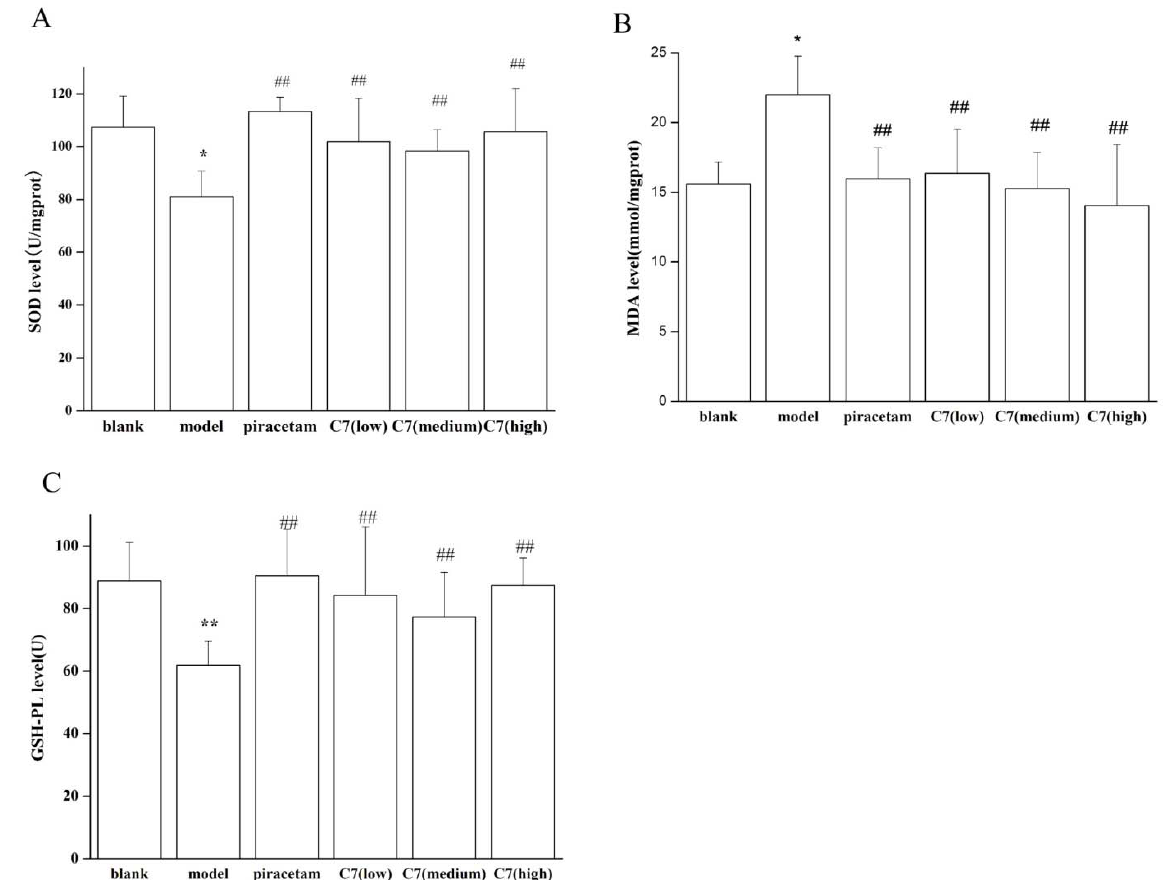
Figure 3. Global cerebral SOD ( A ) MDA ( B ) GSH-PX ( C ) levels for all.